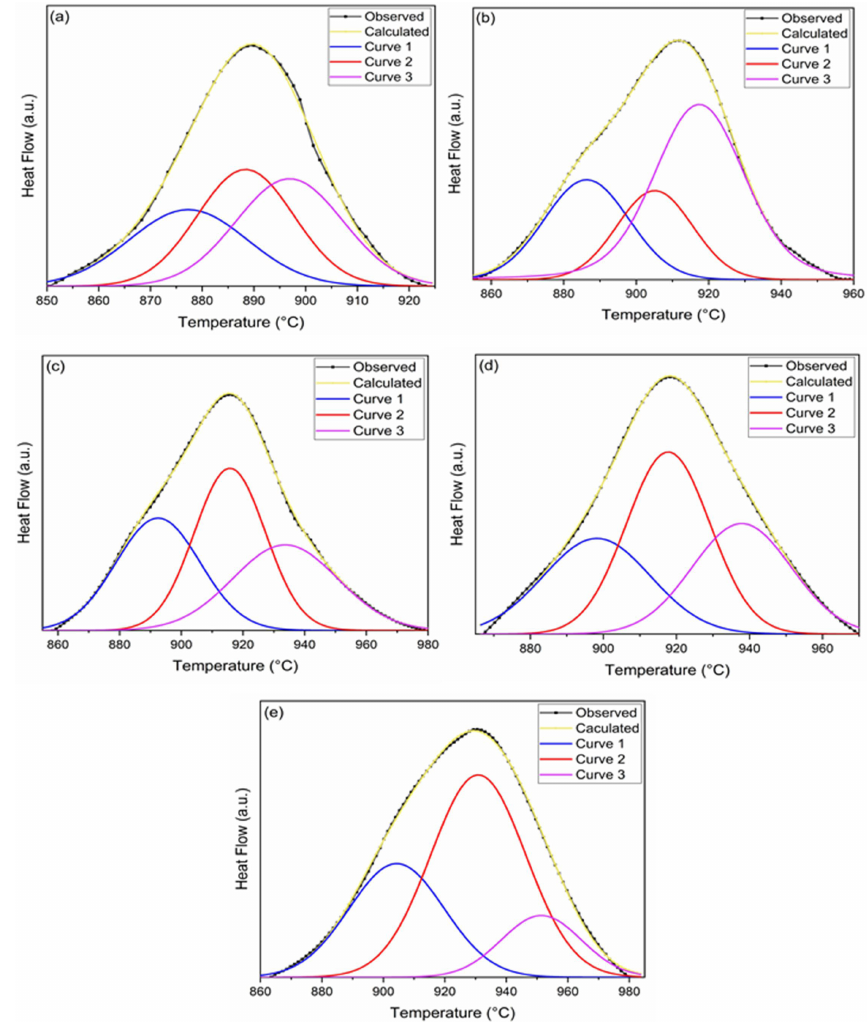
Figure 10. Deconvolution of the Ca Glass crystallization peaks. Heating rate of (a) 10 ºC/min, (b) 15 ºC/min, (c) 20 ºC/min, (d) 25 ºC/min and (e) 30